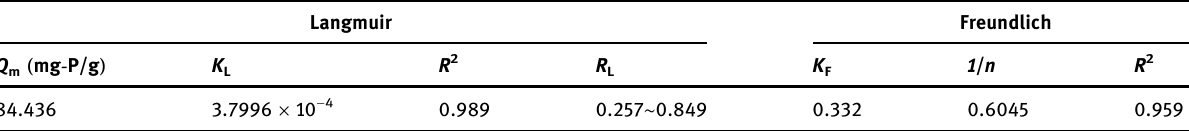
Table 5: The isothermal adsorption fi tting parameters of Langmuir and Freundlich